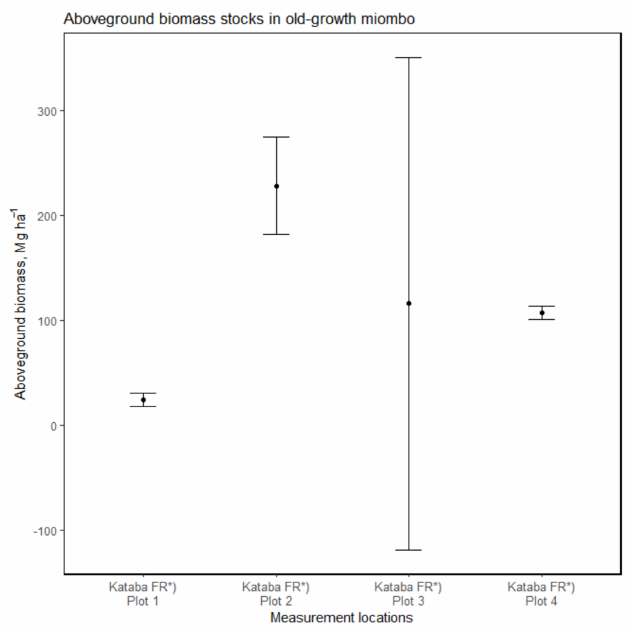
Figure 4. Old-growth AGB data for cases selected for case study I in Kataba Forest Reserve, Zambia (data from [24], ordered by increasing standard deviation). The forest is characterized by a projected canopy cover of nearly 70% [26] and is commonly described as a “woodland” [25]. Source: Graph by the authors based on data in